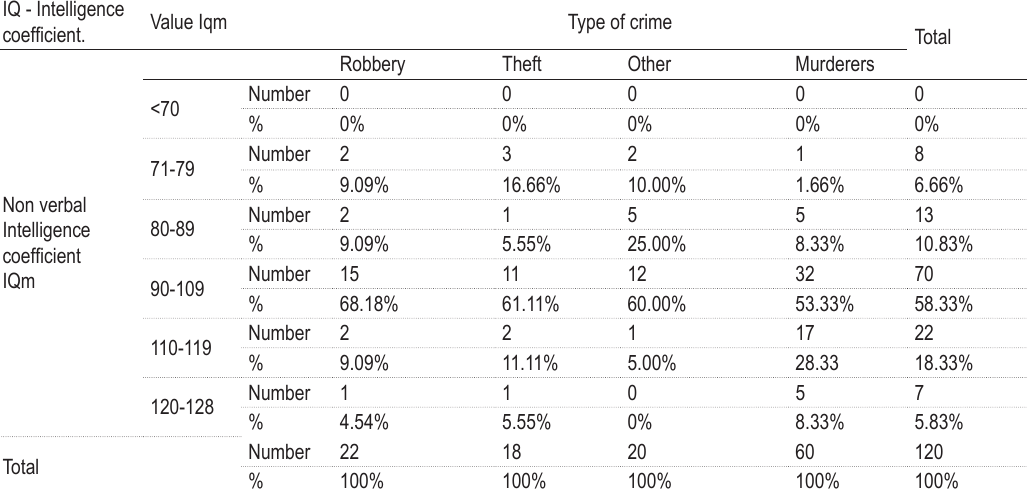
TABLE 5. Structure of IQm (non-verbal or manipulative intelligence coef fi cient) for each group of inmates with regard to the type of IQ - Intelligence coef fi cient.